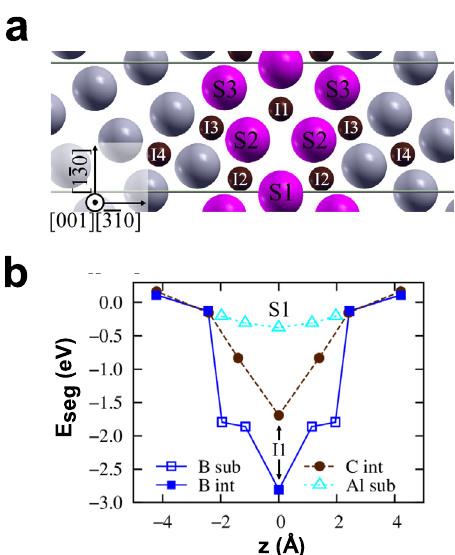
Fig. 7 Solute segregation energies at the GB. a shows the GB (highlighted by the purple atoms) with the interstitial sites (I1-I4), where ( c and b ) were placed, and substitutional sites (S1-S3). b contains a plot of segregation energies of Al to substitutional sites (empty symbols), c to interstitial sites (solid symbols), and B to both substitutional and interstitial